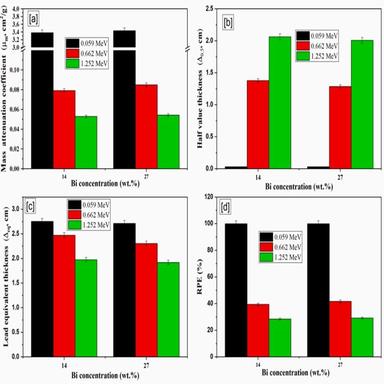
Impacts of the doping Bi concentrations on (a) Mass attenuation coefficient, (b) linear and half-value thicknesses, (c) lead equivalent thickness (Δeq, cm), and (d) Radiation protection efficiency.